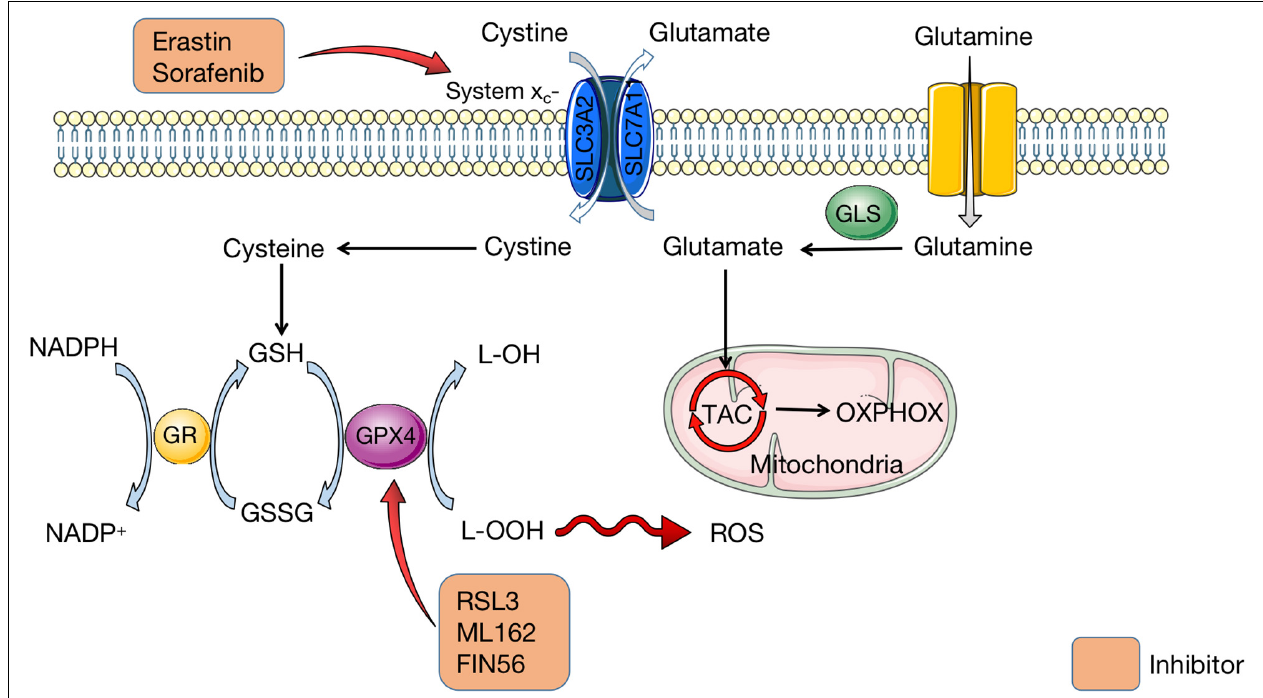
FIGURE 2 | Amio acid metabolism in ferroptosis. Containing two subunits (SLC3A2 and SLC7A11), system x c - is the cystine/glutamate reverse transporter on cell membrane, which transports cystine into cells and glutamate outside cells. Glutamate is transferred from glutamine, which is mediated by GLS. Then glutamate is imported into mitochondria for TAC to synthesize OXPHOX. In cells, cystine is degraded to cysteine for GSH synthesis. GSH is conversed to GSSG under the catalysis of GPX4, synchronized with conversion of L-OOH to L-OH. Meanwhile, NADPH is transferred to NADP+, which is catalyzed by GR. Erastin and sorafenib are inhibitors of system x c - to affect the amio acid metabolism. RSL3, ML162, and FIN56 can inhibit GPX4 and thus lead to excessive L-OOH in cells, which causes ROS accumulation. GLS, glutaminase; TAC, tricarboxylic acid cycle; OXPHOX, oxidative phosphorylation; GSH, glutathione; GSSG, glutathione disulfide; GPX4, glutathione peroxidase 4; NADPH, nicotinamide adenine dinucleotide phosphate; GR, glutathione reductase; RSL3, RAS-selective lethal 3; ROS, reactive oxygen